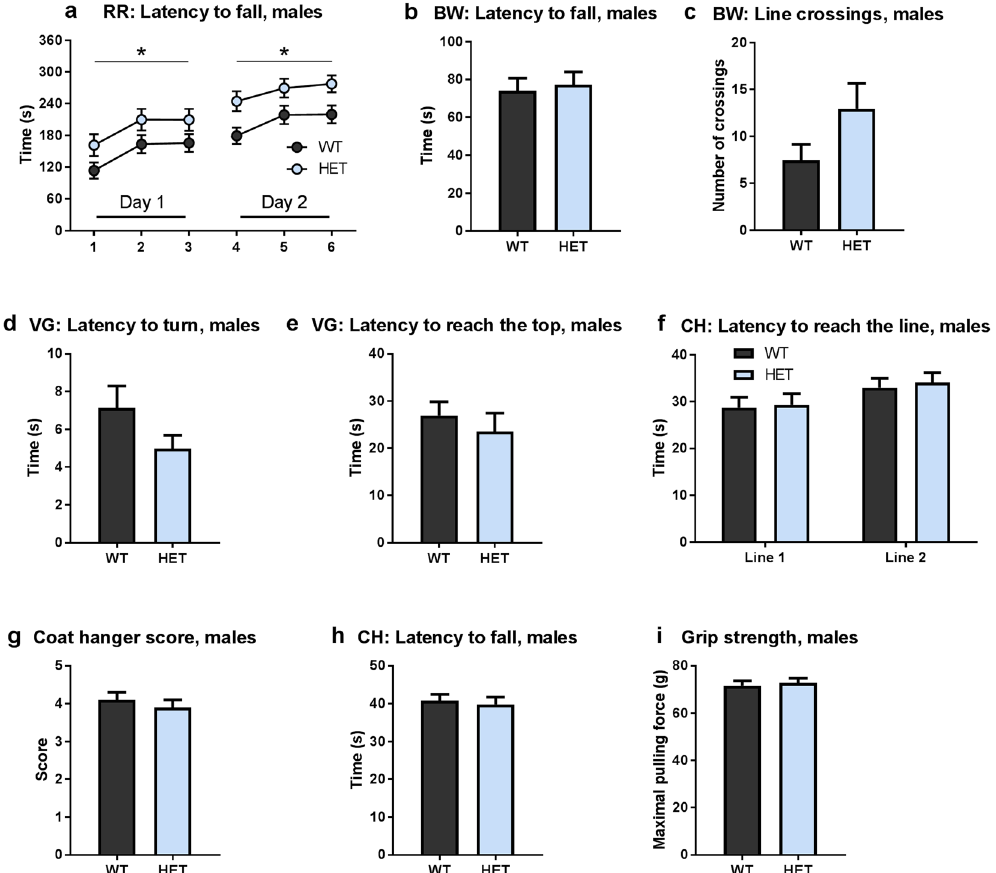
Figure 2. Motor function is improved in Gdnf wt/hyper male mice ( a ) Latency to fall off the accelerating rotarod in each trial. Two-way repeated measures ANOVA, genotype effect Day 1 p = 0.046, Day 2 p = 0.011. ( b ) Latency to fall off the beam in the beam walking test. Mann-Whitney U-test, p = 0.63. ( c ) The number of crossed lines in the beam walking test. Student’s t-test with Welch’s correction, p = 0.092. ( d ) Latency to turn in the vertical grid test. Student’s t-test with Welch’s correction, p = 0.13. ( e ) Latency to reach the top of the grid in the vertical grid test. Student’s t-test, p = 0.48. ( f ) Latency to reach the lines in the coat hanger test. Mann-Whitney U-test, Line 1 (end of horizontal part) p = 0.84, Line 2 (on the diagonal part) p = 0.80. ( g ) Coat hanger test score. Mann-Whitney U-test, p = 0.67. ( h ) Latency to fall in the coat hanger test. Mann-Whitney U-test, p = 0.60. ( i ) Maximal forepaw pulling force in the grip strength test. Student’s t-test, p = 0.70. Abbreviations: BW, beam walking; CH, coat hanger; RR, rotarod; VG, vertical grid. ( a – c ) N = 34 Gdnf wt/wt , 31 Gdnf wt/hyper . ( d – h ) N = 24 Gdnf wt/wt , 21 Gdnf wt/hyper . ( i ) N = 33 Gdnf wt/wt , 31 Gdnf wt/hyper . Data is presented as mean ± SEM. * p <